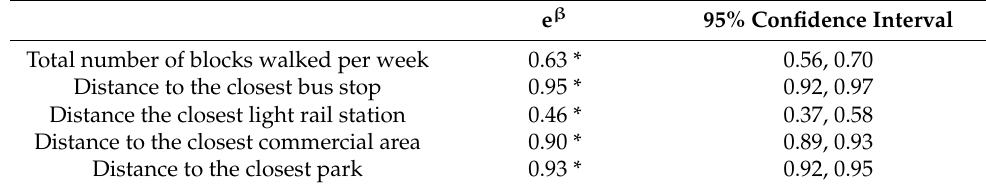
Table 2. Change statistics of the total number of blocks walked per week and the built environment during follow-up from the “change” models. e β 95% Confidence Interval Total number of blocks walked per week 0.63 * 0.56, 0.70 Distance to the closest bus stop 0.95 * 0.92, 0.97 Distance the closest light rail station 0.46 * 0.37, 0.58 0.90 * 0.89, 0.93 0.93